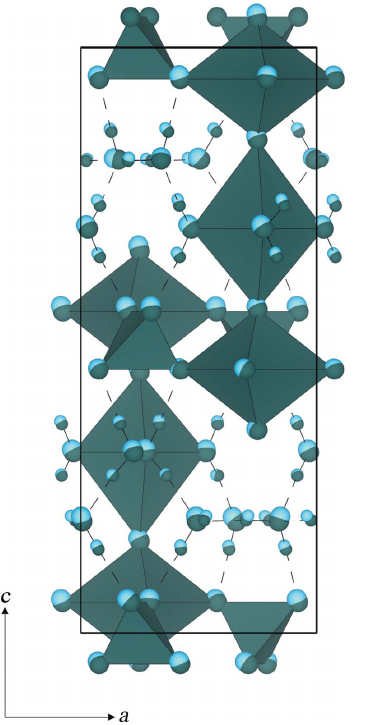
Figure 6 Structure-overlay diagram of the final optimized geometry from AIRSS (shown in light blue) onto the structural model obtained via structural refinement of NPD data (shown in dark teal).